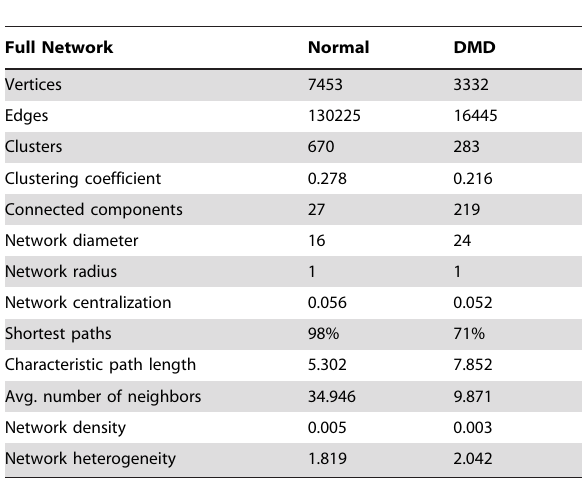
Table 2. Summary of network